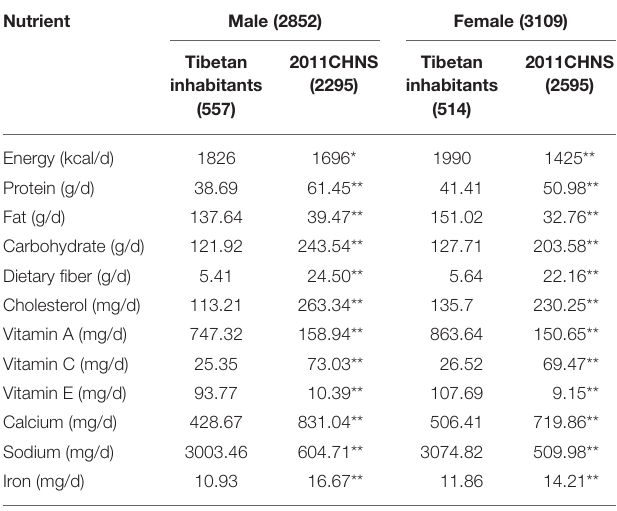
TABLE 5 | Daily nutrient intakes of inhabitants in high altitude compared with 2011CHNS by sex.